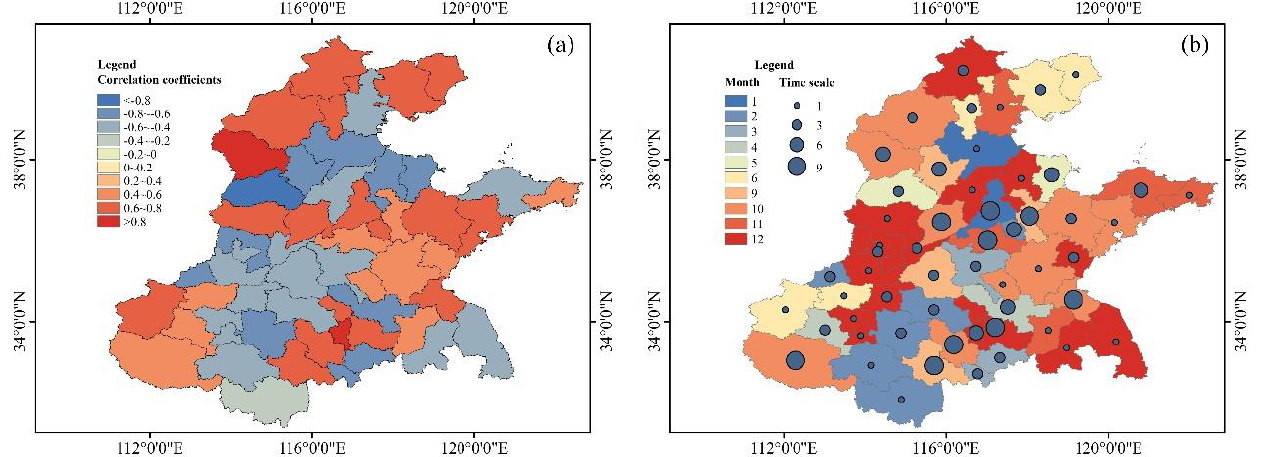
Figure 5. ( a ) Spatial distribution of the optimal correlation coefficient between the SPEI and the SYRS in 55 cities in the NCP. ( b ) Month and time scales corresponding to the maximum correlation coefficient, based on ( a ).